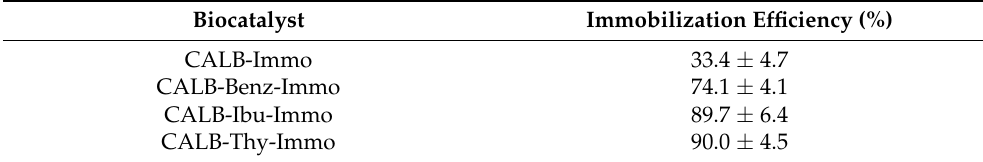
Table 2. Efficiency of protein immobilization in the synthesis of biocatalysts.